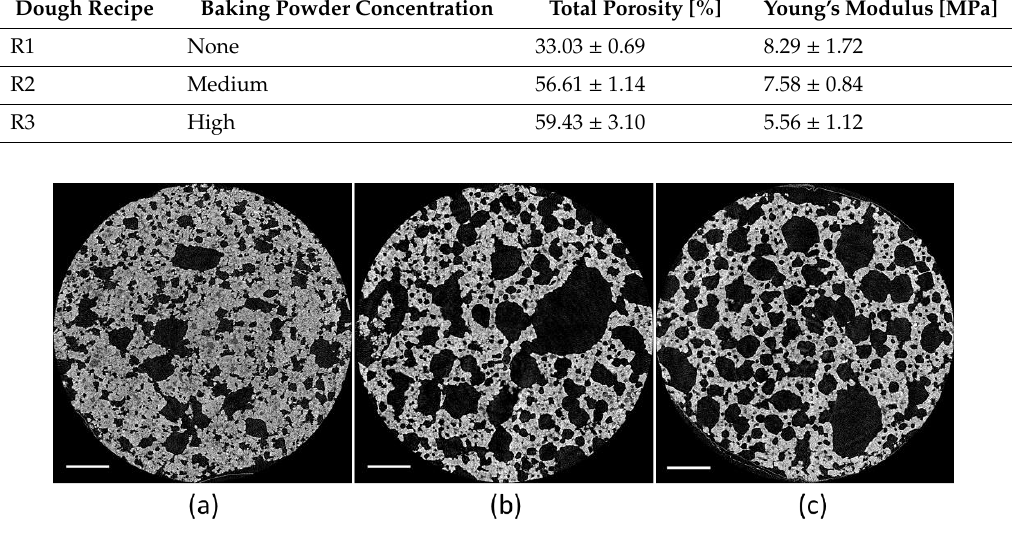
Figure 1. Cross-sections of cookie samples produced with recipes R1 ( a ), R2 ( b ), and R3 ( c ) (Table 1). The scale bars correspond to 800 µm. Increasing porosity can be noticed with higher baking powder concentration.